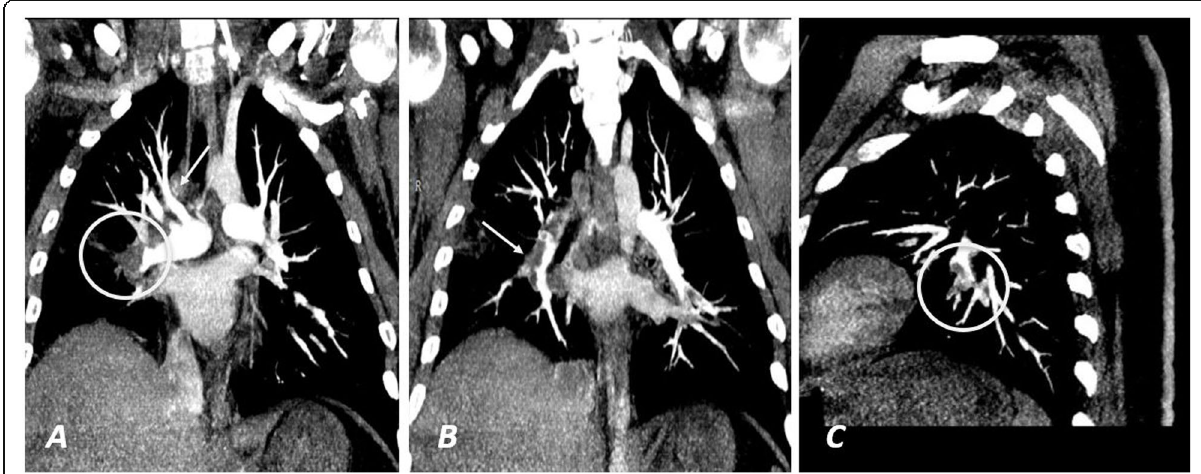
Fig. 3 a , b Coronal maximum intensity projection (MIP) and c sagittal MIP images of the same patient in Fig. 2. A thrombus was noted involving the right inter-lobar artery (white circle in a ) after the origin of the right upper lobar artery (white arrow in a ) causing its partial occlusion (white arrow in b ). Another thrombus was noted affecting the segmental branches of the left lower lobar artery (white circle in c )